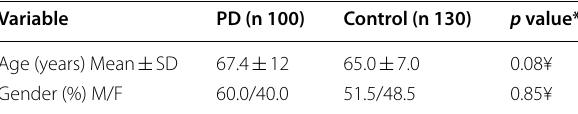
Table 2 Non-motor manifestations in Parkinson’s disease patients and control